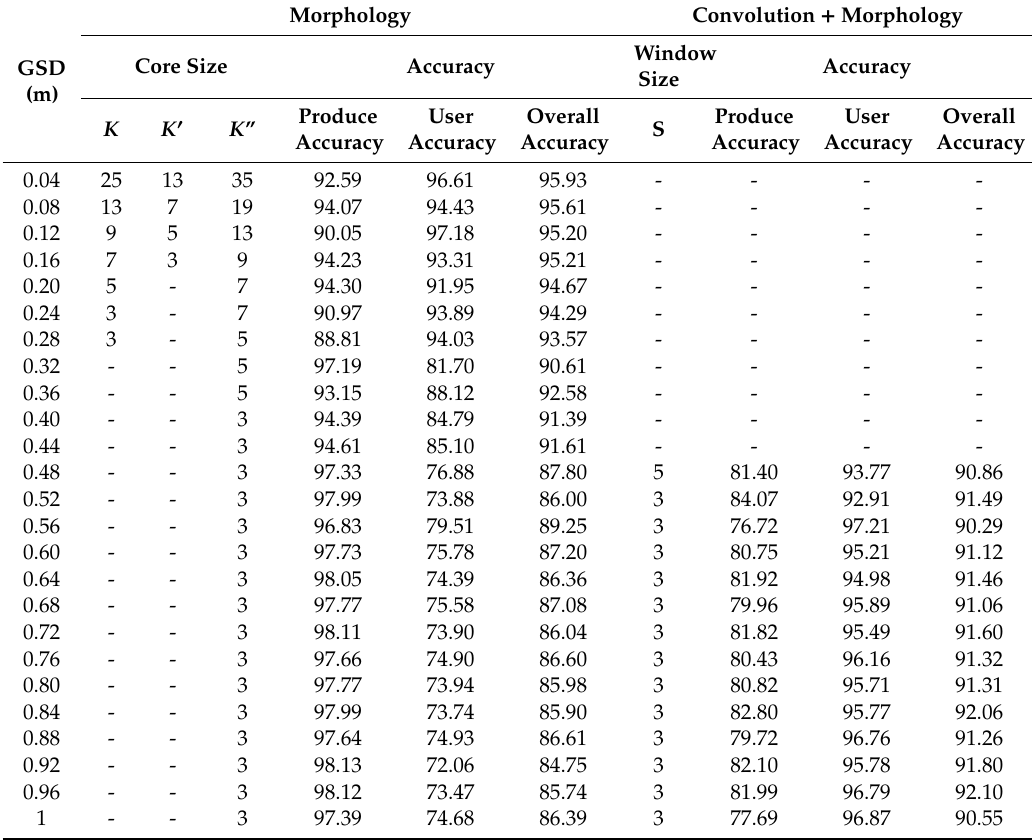
Table 3. Accuracy and parameters of tobacco field identification by using di ff erent image ground sampling distance (GSD).